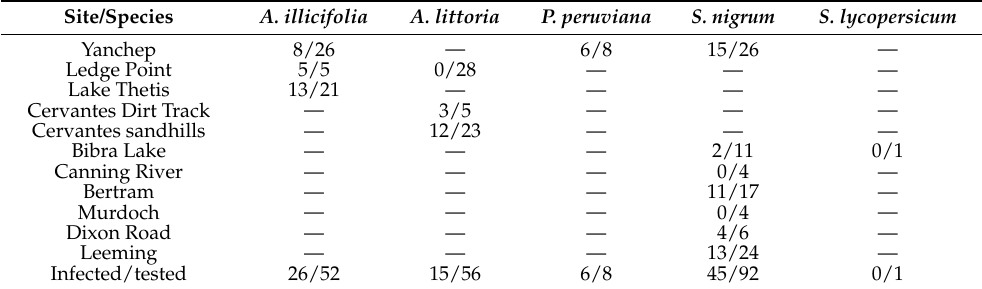
Table 1. Natural infection with YTMMV at 11 sites. Numbers represent plants infected with YTMMV as a fraction of the total number of plants tested at each